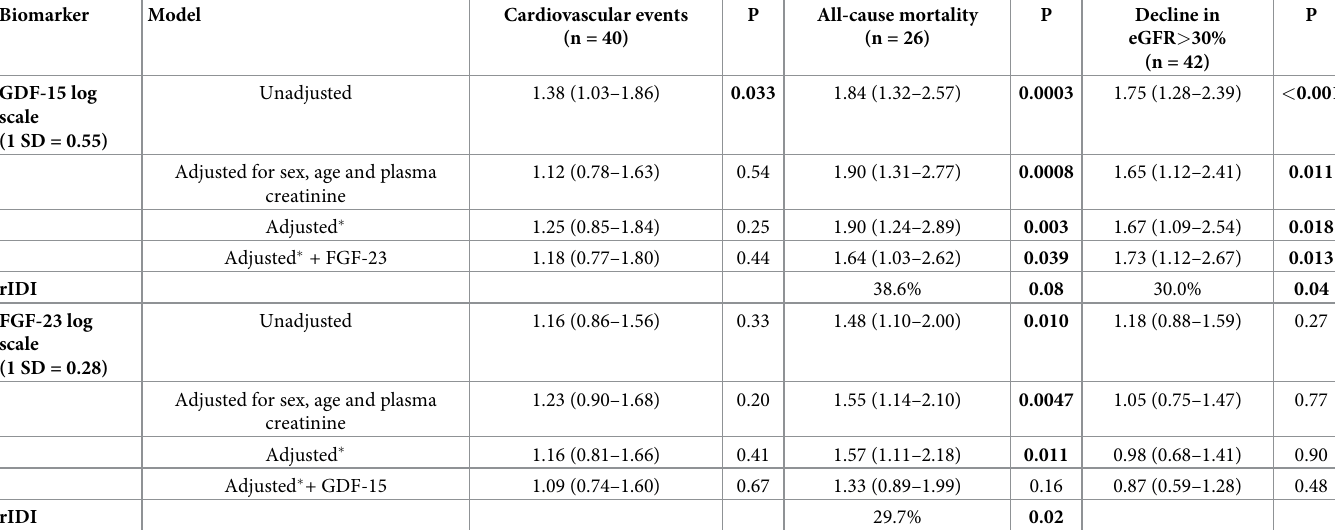
Table 2. Stepwise Cox regression analyses: Biomarkers in relation to risk of fatal and nonfatal cardiovascular events, all-cause mortality and decline in eGFR > 30% in 200 patients.